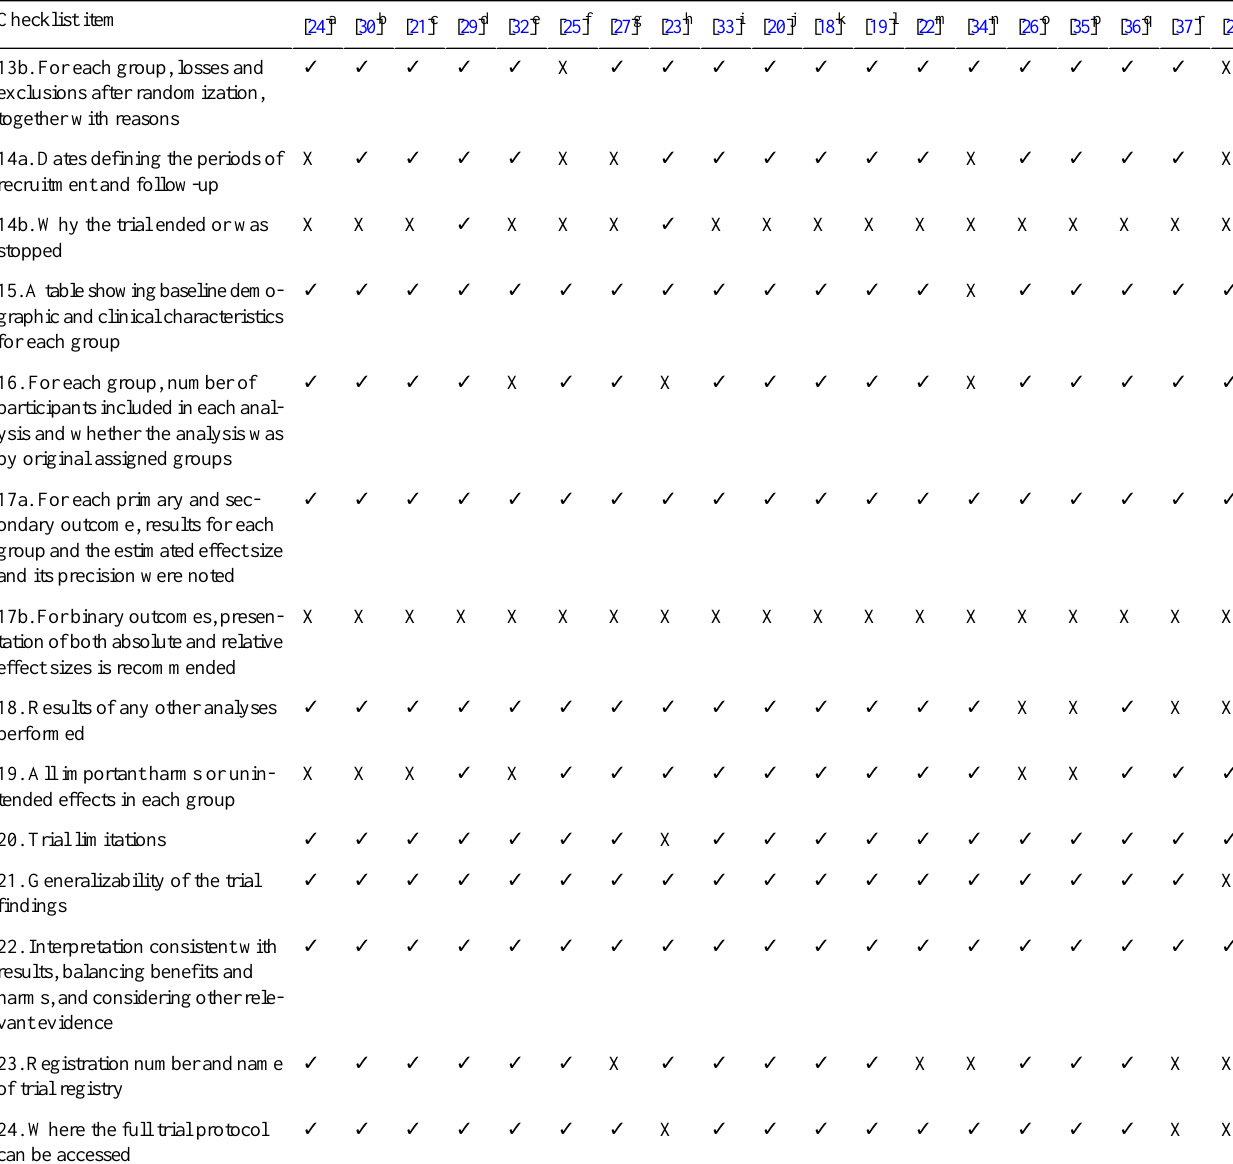
✓✓✓✓✓ X ✓✓✓✓✓✓✓✓✓✓✓✓✓ 15. A table showing baseline